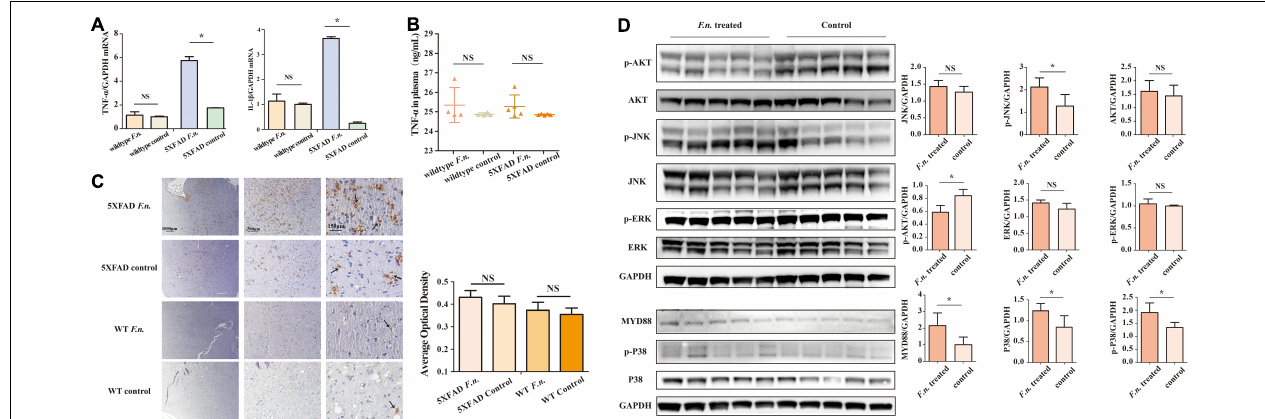
FIGURE 4 | F. nucleatum could promote inflammatory processes in 6-month-old 5XFAD mice brain. (A) The expression levels of genes of TNF- α and IL- β in the brain tissue of 5XFAD mice and wild-type mice. (B) The concentration of TNF- α in mice plasma. (C) The distribution of microglia in mice cerebrum cortex. (D) The expression levels of proteins in inflammation-related pathways in 5XFAD mice brain. All data were expressed in mean ± SD, n = 5, *P < 0.05 vs. the control group. NA, not significantly